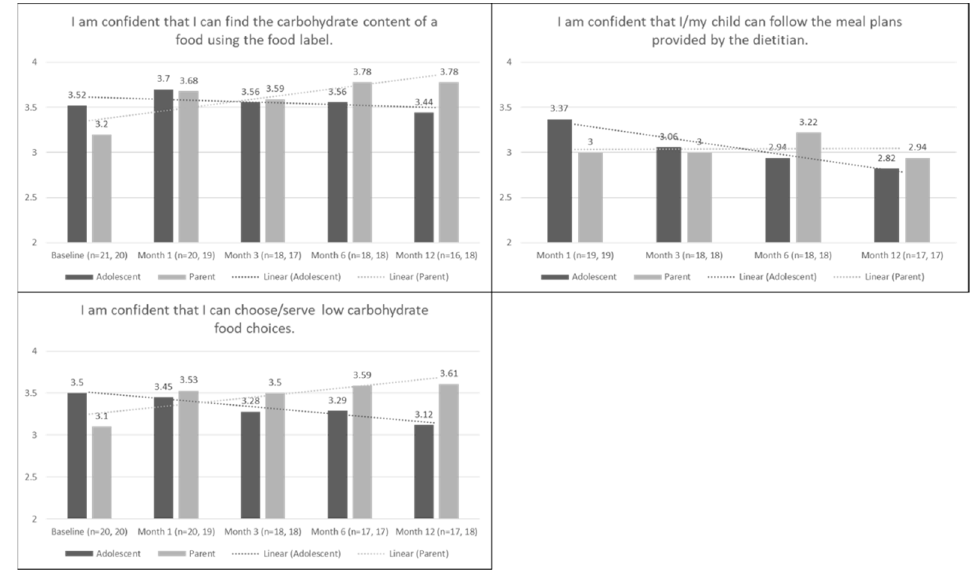
Figure 1. Adolescent and parent mean trends in confidence over 12 months.